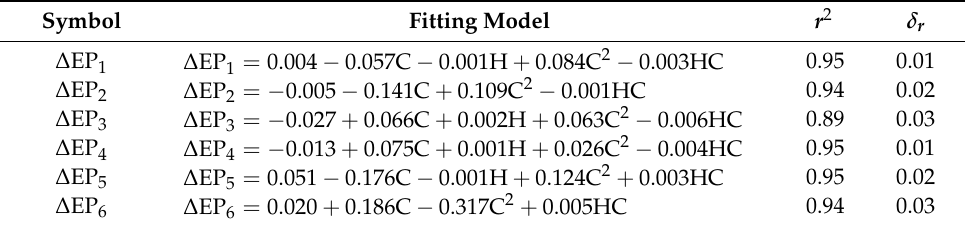
Table 4. The detailed regression results of the fitting models, the CODs and the RMSEs for the DEPs. Symbol